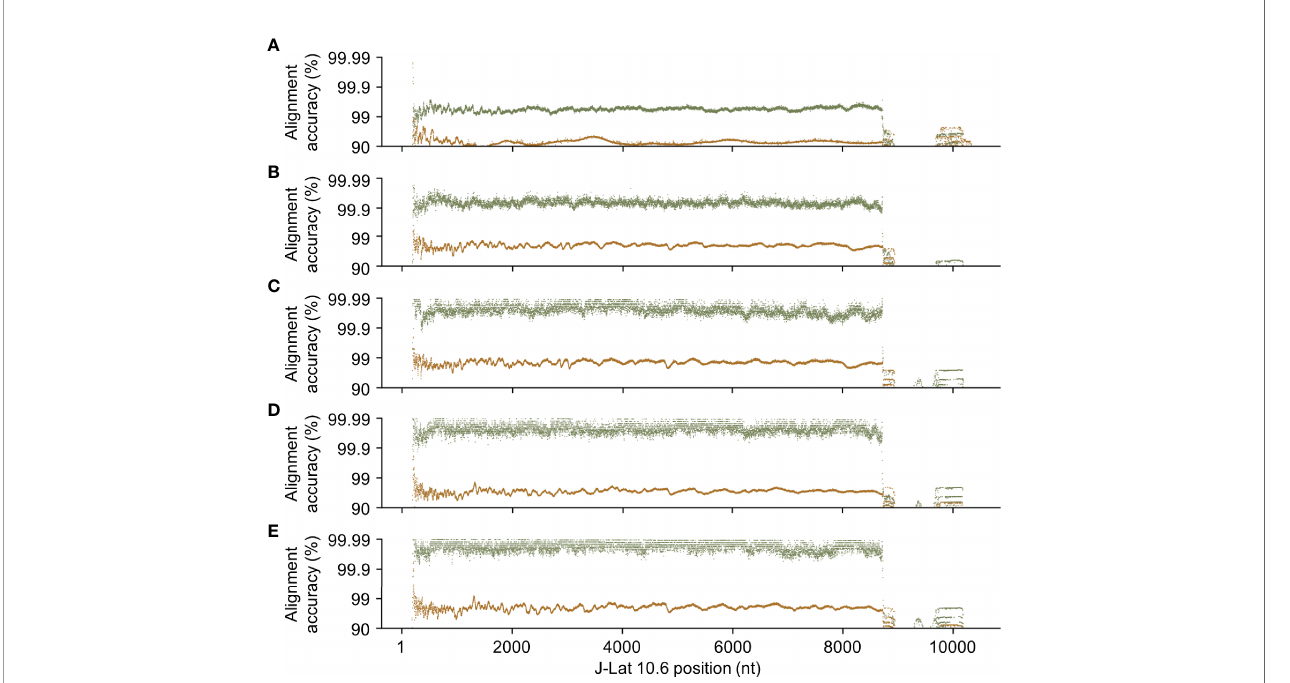
FIGURE 6 | HIV-Quasipore basecallers improved read quality across the entire HIV-1 genome. Each point represents the average alignment accuracy from reads overlapping a position within the J-Lat 10.6 reference genome for (A) R9.4.1 fast, (B) R9.4.1 HAC, (C) R9.4.1 SUP, (D) R10.3 HAC, and (E) R10.3 SUP basecallers. Green points represent HIV-Quasipore basecallers while brown points represent their pretrained